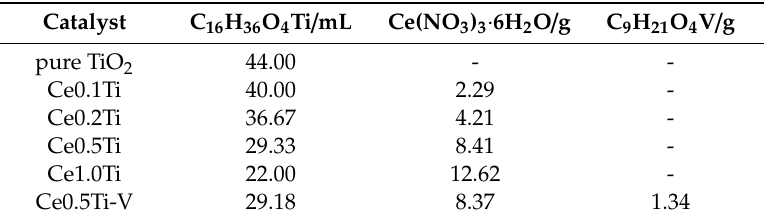
Table 1. The amounts of the precursors used in the preparation process.